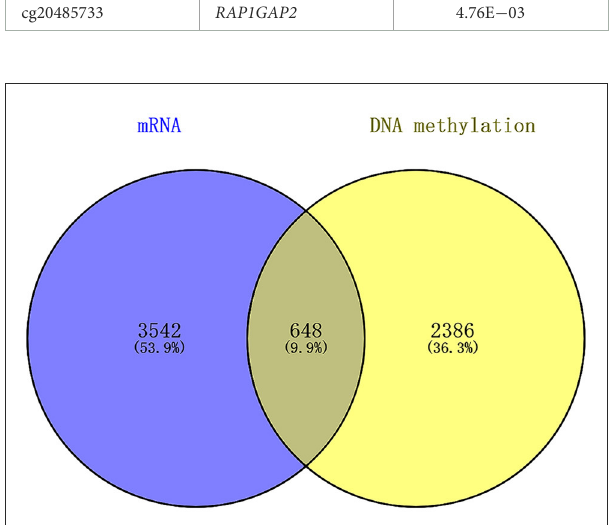
FIGURE5 Overlap between the differentially expressed mRNAs and DNA methylation positions between first-episode, drug-naive adolescents with MDD and healthy